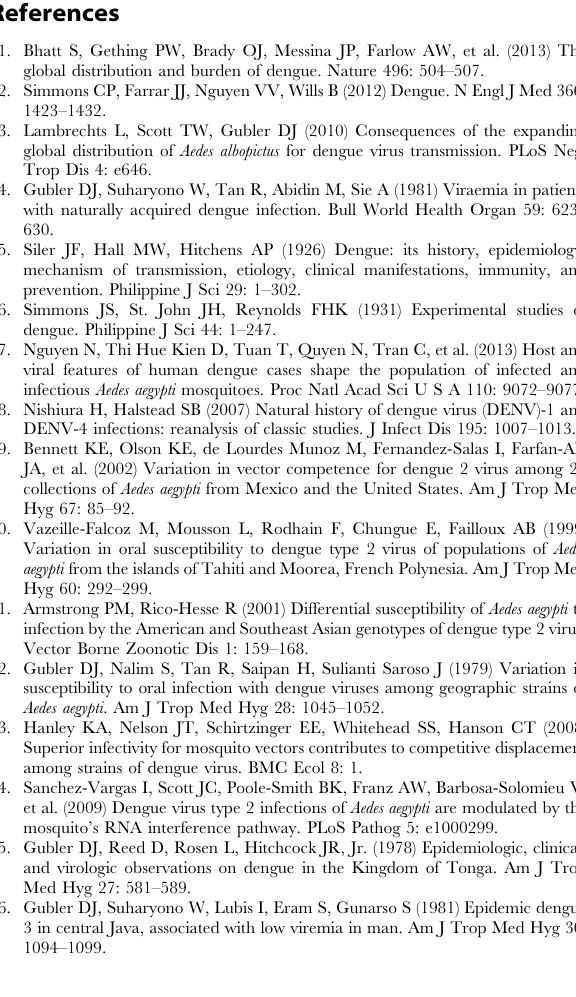
Table S1 Sample sizes. For each combination of mosquito population, virus isolate and infectious dose, the number of individual mosquitoes assayed (N) is